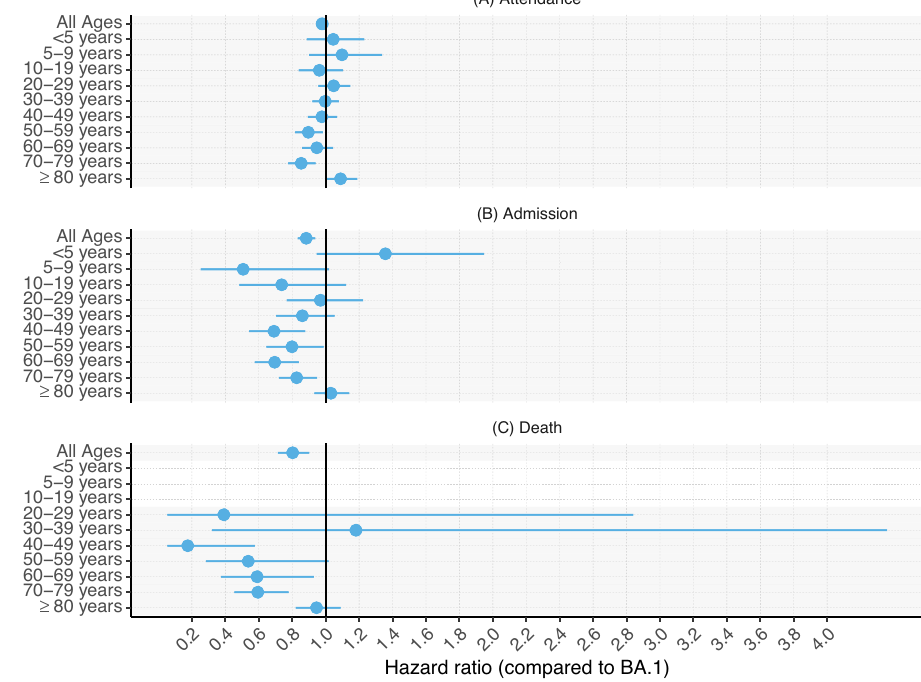
Fig.2|Relativeriskofattendance,admissionordeath,BA.2versusBA.1byage group. Risk of hospitalisation and mortality, overall and by age group,